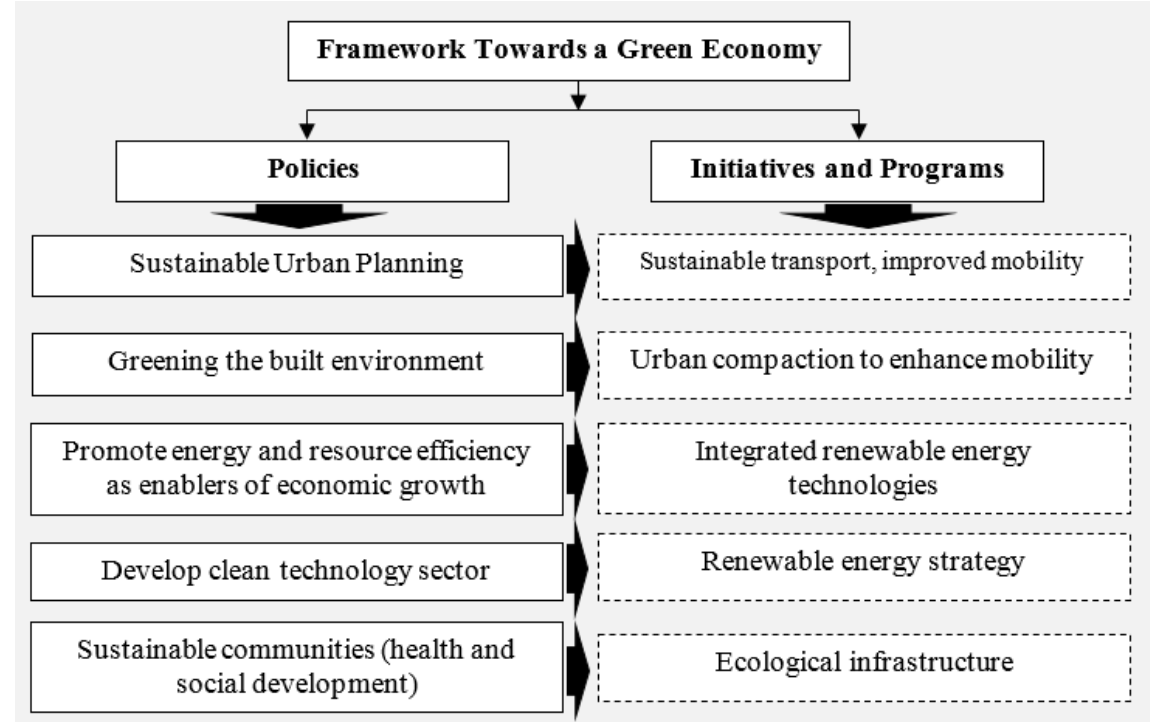
Figure 4. The strategic framework towards a green economy Reference: The